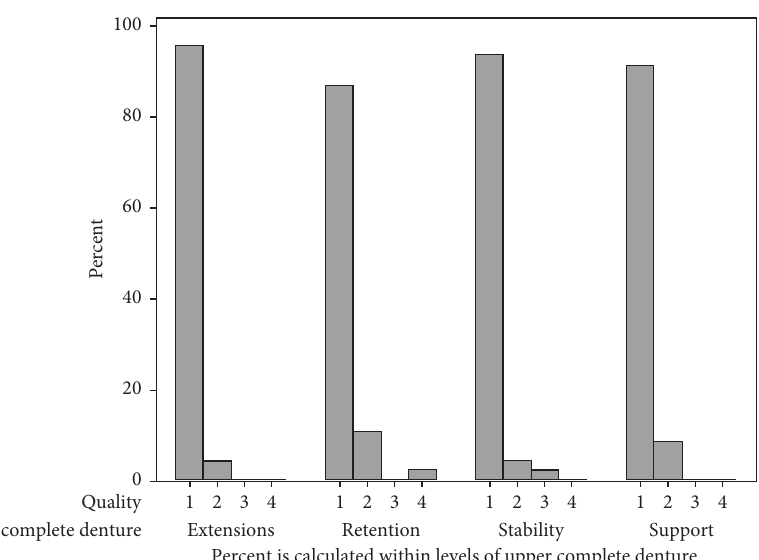
Figure 4: Level of satisfaction with the upper complete denture in relation to stability, support, and